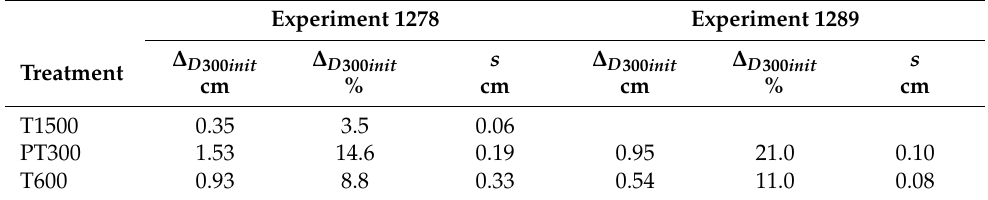
Table 5. Quantification of the selection effect depending on thinning practice based on change in D 300